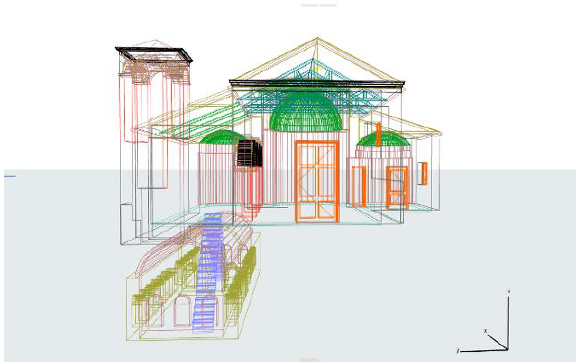
Figure 9. Reconstruction of Building Information